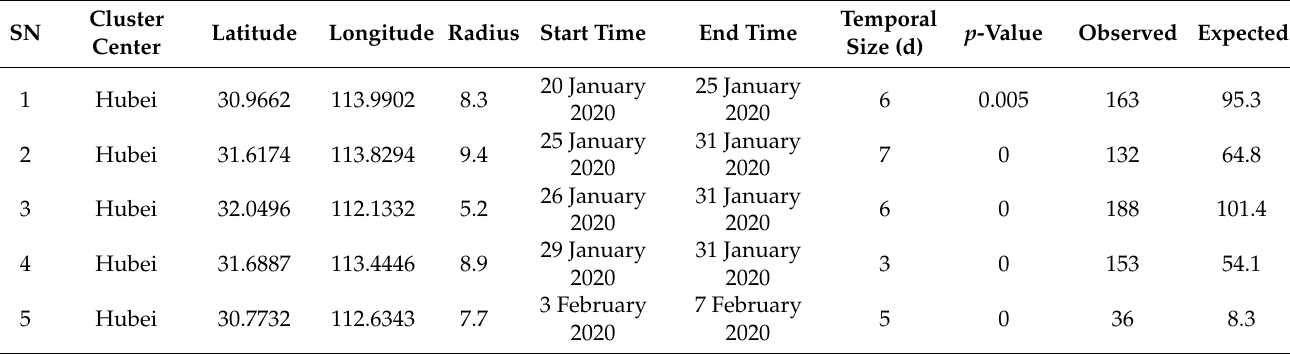
Table 2. Characteristics of the statistically significant space-time clusters of COVID-19 at the family-level with a maximum spatial scanning window size of 10 km in mainland China from 2 December 2019 to 20 June 2020 (clusters where all cases happen in the same geo-location are reported as having 0 km